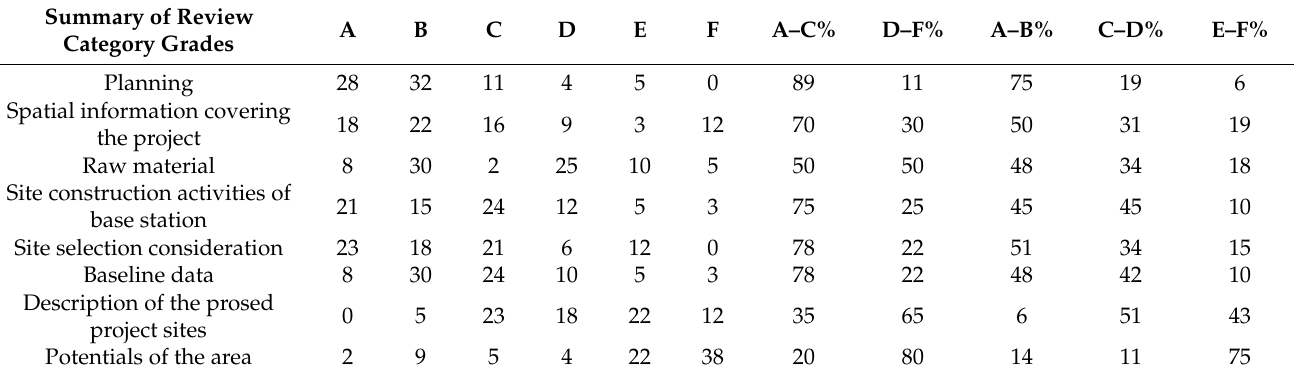
Table 5. Allocation of quality to environmental assessment tasks performed under Review Area